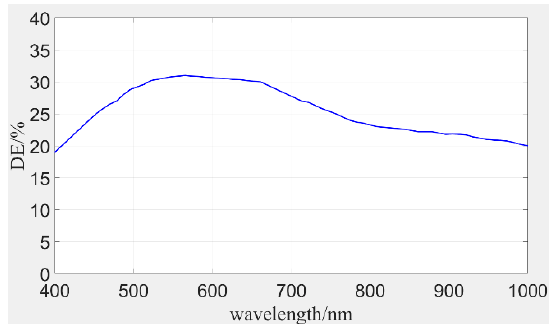
Figure 2. The diffraction efficiency of the grating. Figure 3. The quantum efficiency of the CMOS.